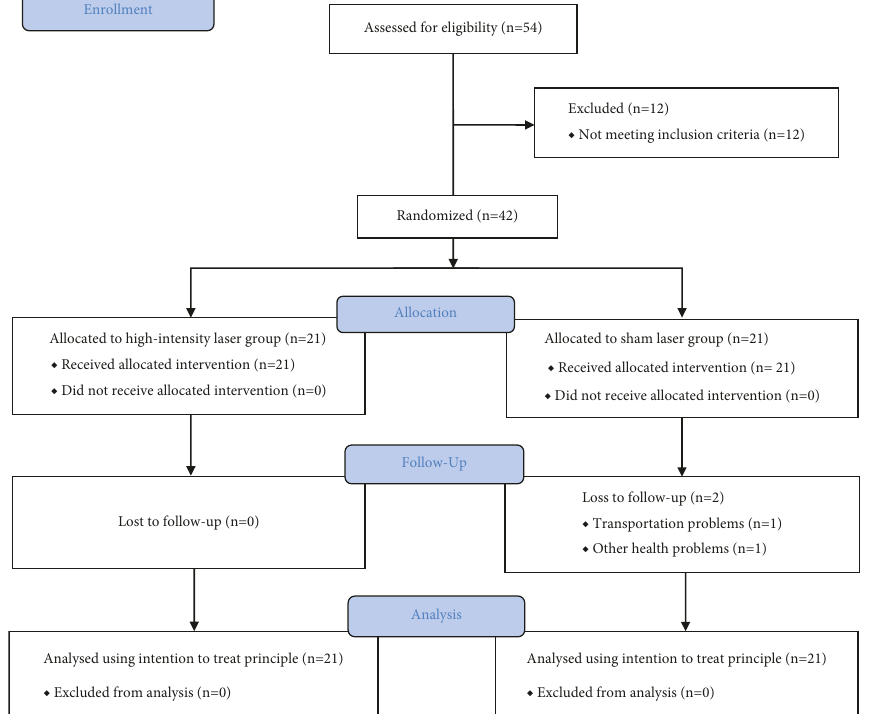
Figure 1: Consort diagram of the study